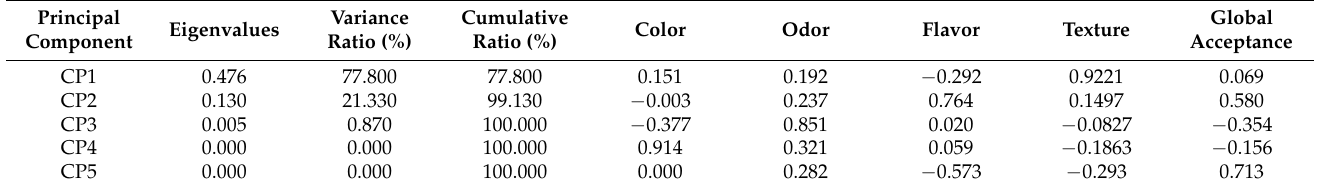
Table 6. Main components related to the sensory evaluation of Minas Frescal cheeses produced from lactating goats fed diets with increasing levels of licury